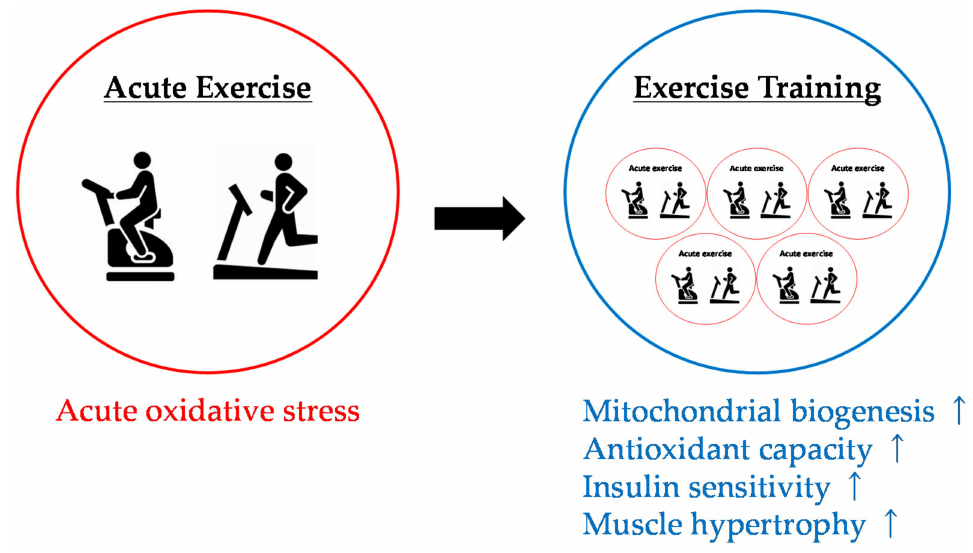
Figure 3. Reactive species and physiological adaptations to endurance